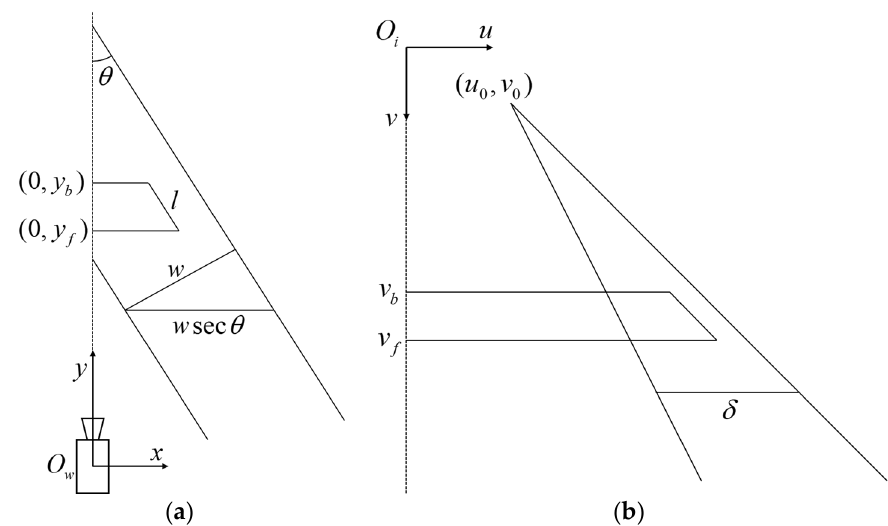
Figure 3. A line segment in the world coordinate system and its projection in the image. ( a ) World coordinate system; ( b ) Image coordinate system.